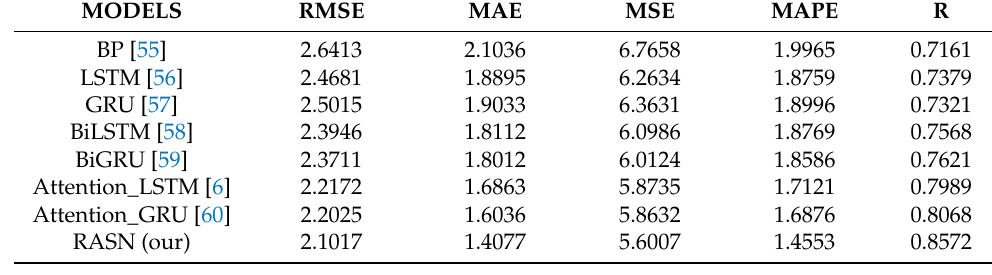
Table 3. Comparison of model prediction performance based on humidity data.